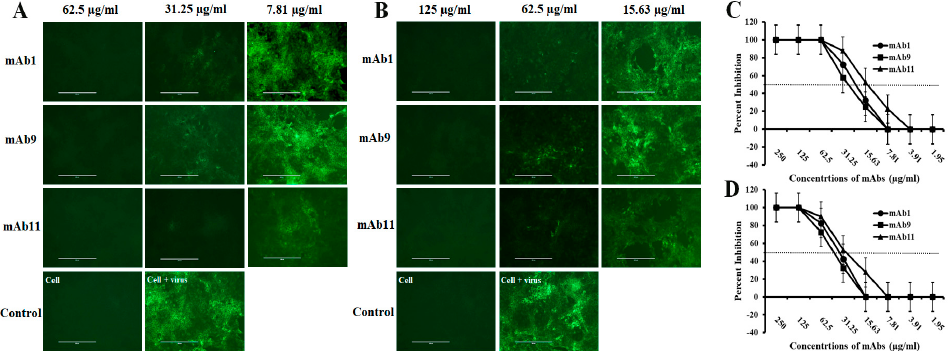
Figure 6. IFA testing the neutralizing activity of porcine mAbs (mAb1, mAb9, mAb11) against CSFVs. ( A ) IFA testing the neutralizing activity of porcine mAbs against the CSFV C-strain. ( B ) IFA testing the neutralizing activity of porcine mAbs against the CSFV Alfort strain. 4 days post infection (DPI). No green fluorescent signal means 100% inhibition. Scale bar: 200 µ m. ( C ) Percentage inhibition of porcine mAbs against the CSFV C-strain. ( D ) Percentage inhibition of porcine mAbs against the CSFV Alfort strain. The do tt ed line represents IC 50 (half maximal inhibitory concentration) value.